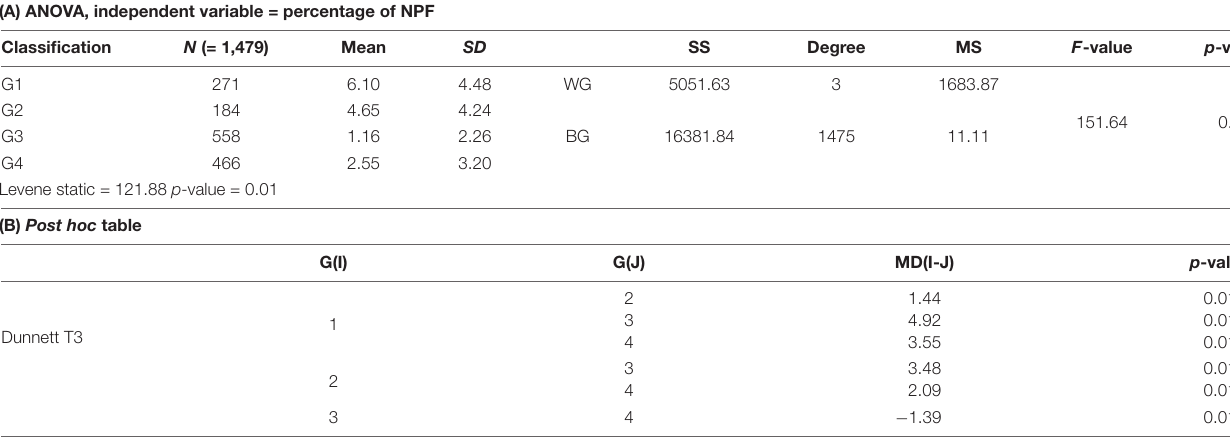
TABLE 7 | ANOVA and post hoc analysis for all industries.